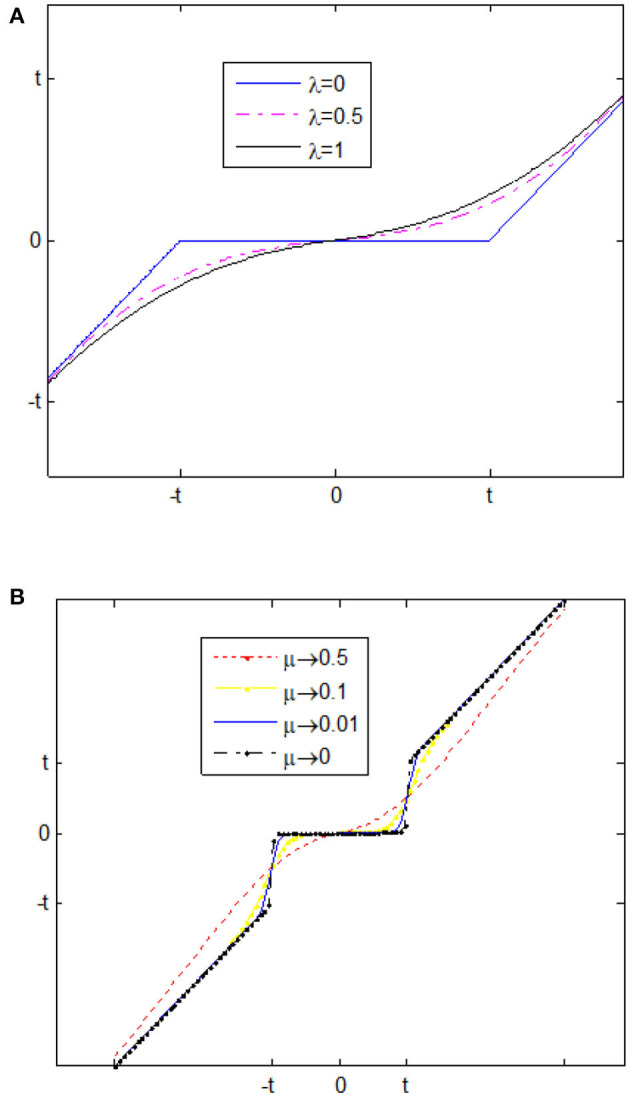
(A) is Zhang's improved soft threshold, and (B) is Zhang's improved hard threshold (Zhang, 2001).